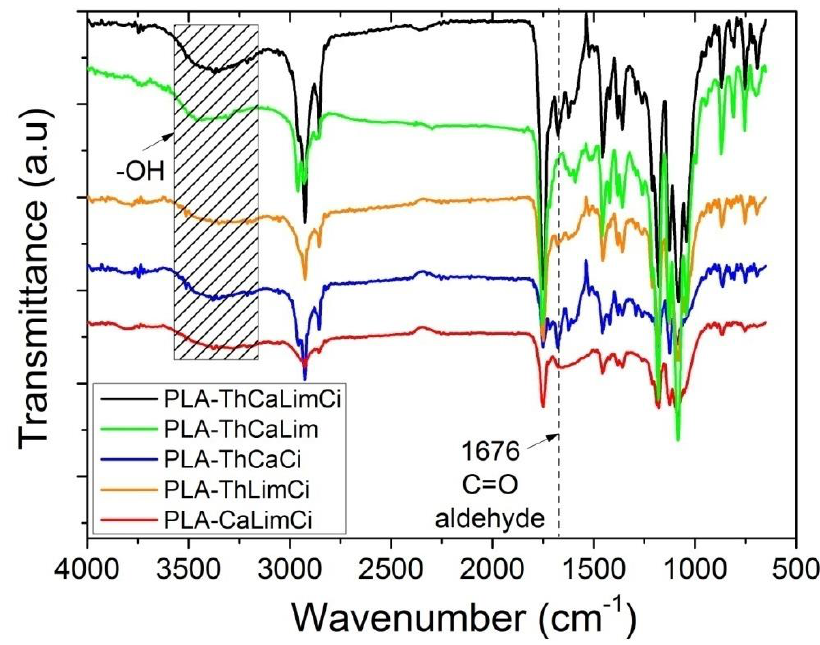
Figure 4. FTIR spectra of the PLA composites with all triple mixtures and the quadruple mixture of thymol, carvacrol, limonene or cinnamaldehyde.